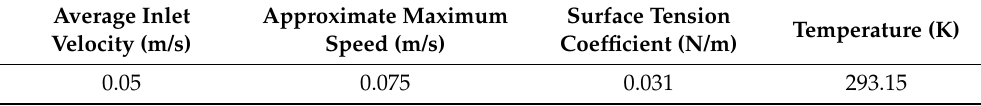
Table 2. The setting